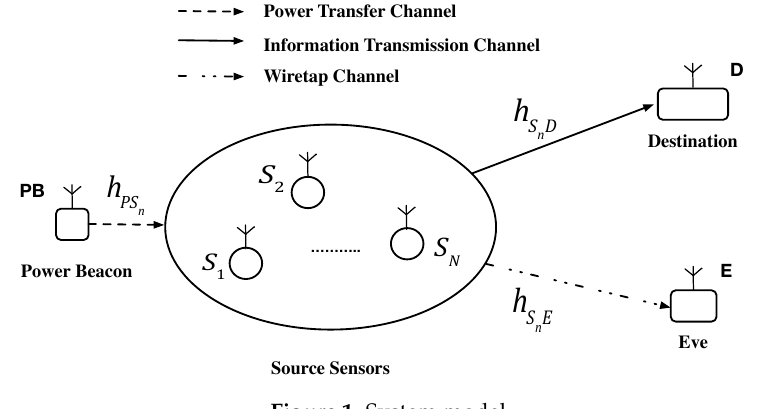
Figure 1. System